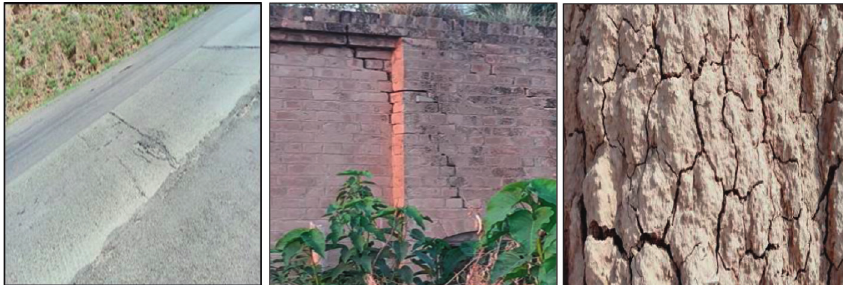
Figure 1: Damages due to the presence of expansive soil and desiccation